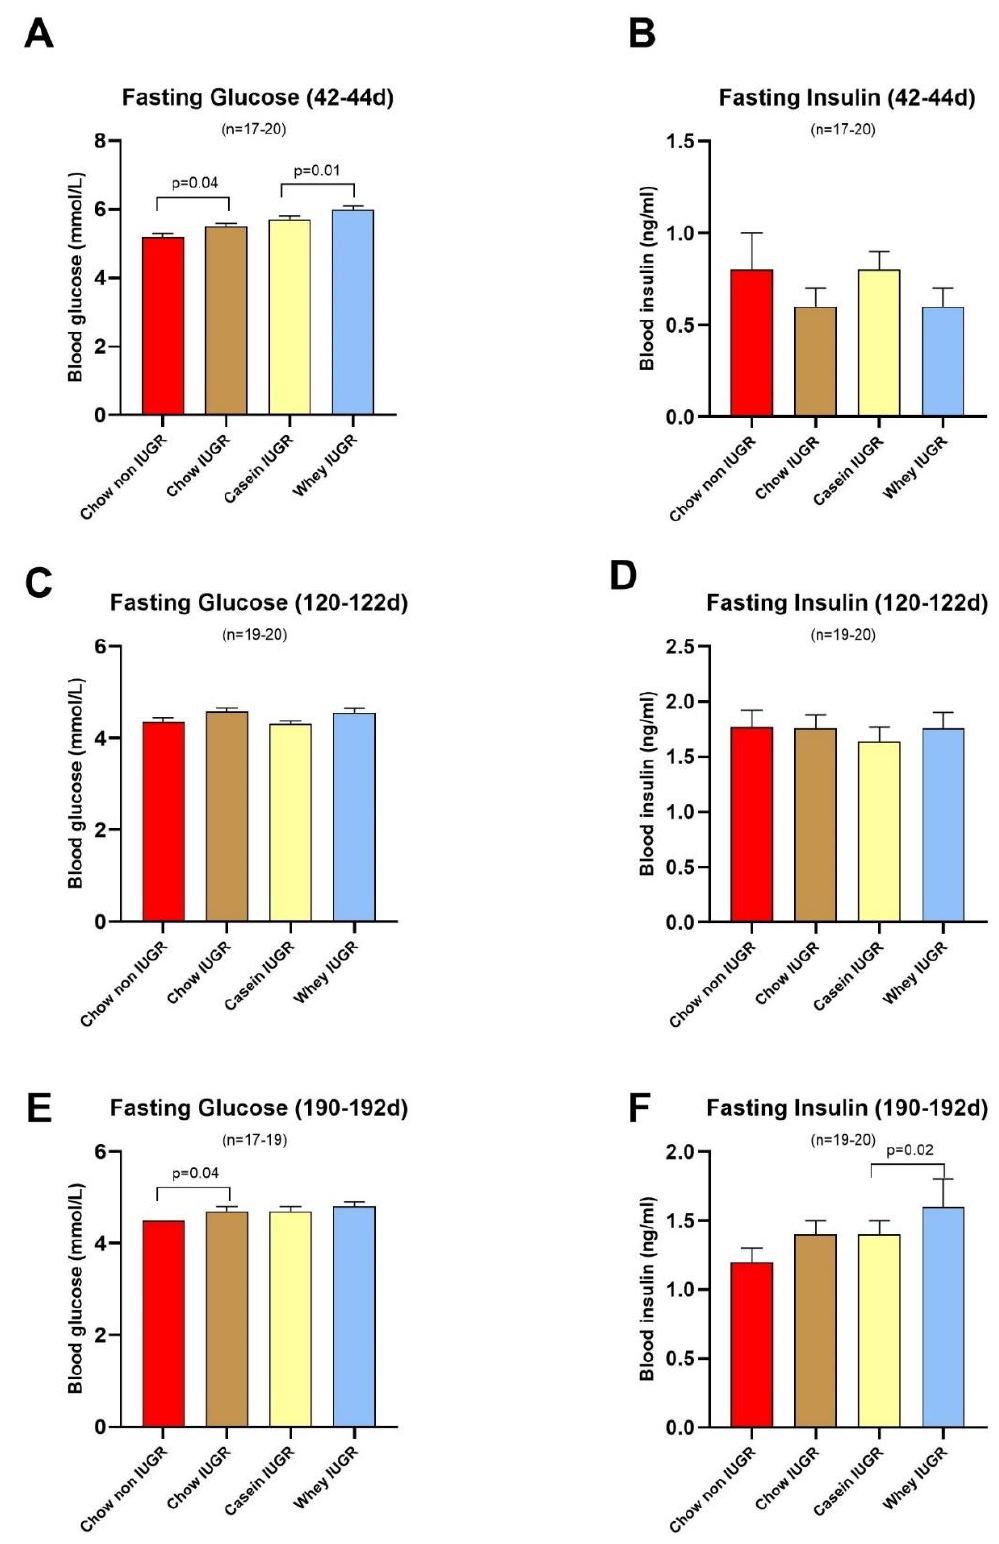
Figure 4. Fasting Glucose and Insulin values. Fasting glucose and insulin at days 42 (( A ) and ( B ), respectively), 92 (( C ) and ( D ), respectively), and 121 (( E ) and ( F ), respectively); n = 17–20 per group; values are median ± SE median.